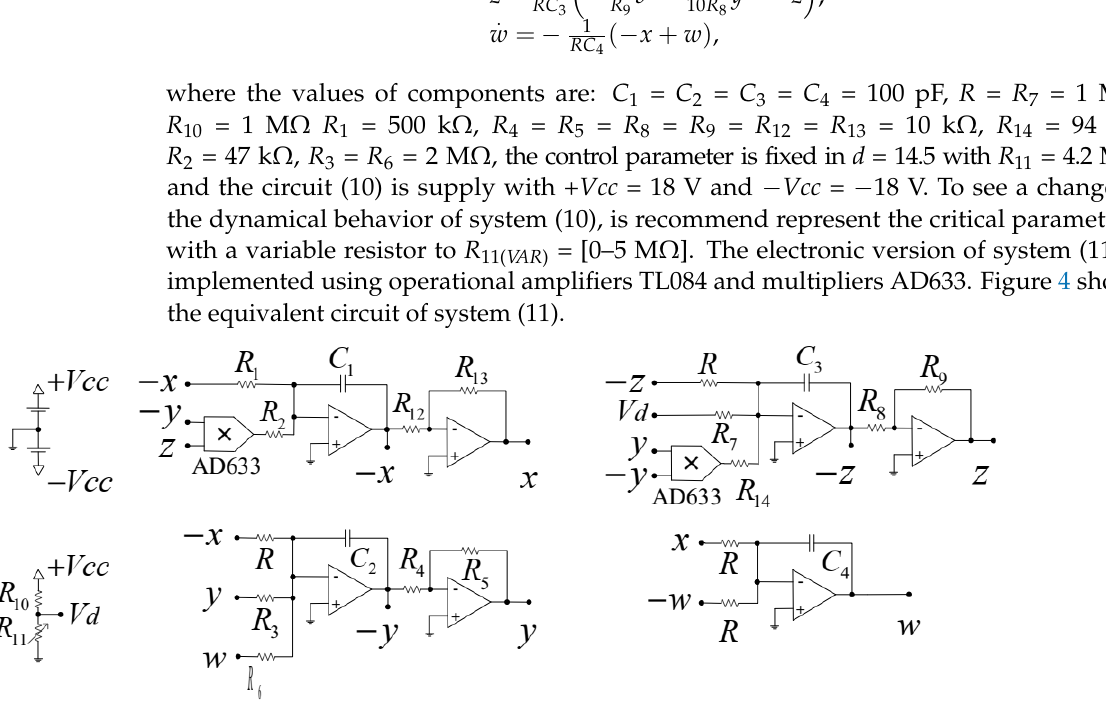
Figure 4. Schematic diagram of the equivalent circuit of system